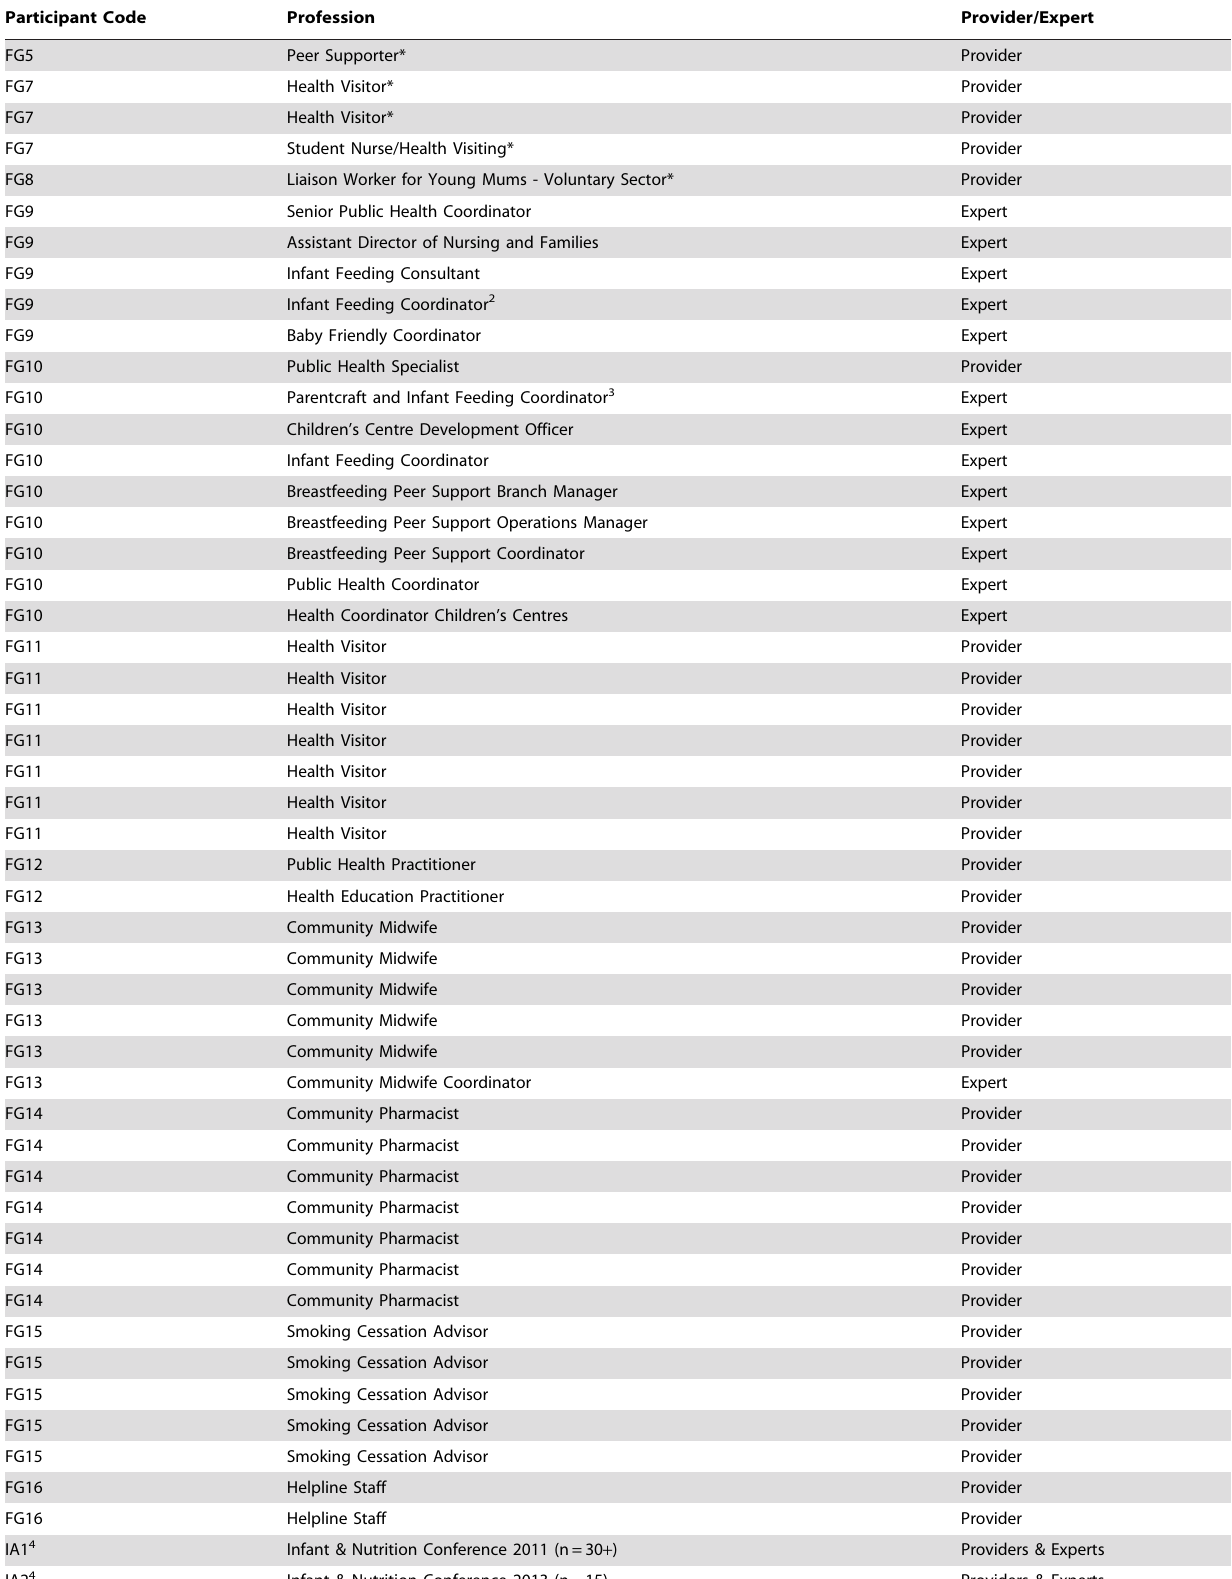
Table 8. Focus groups & interactive discussions – providers/experts 1